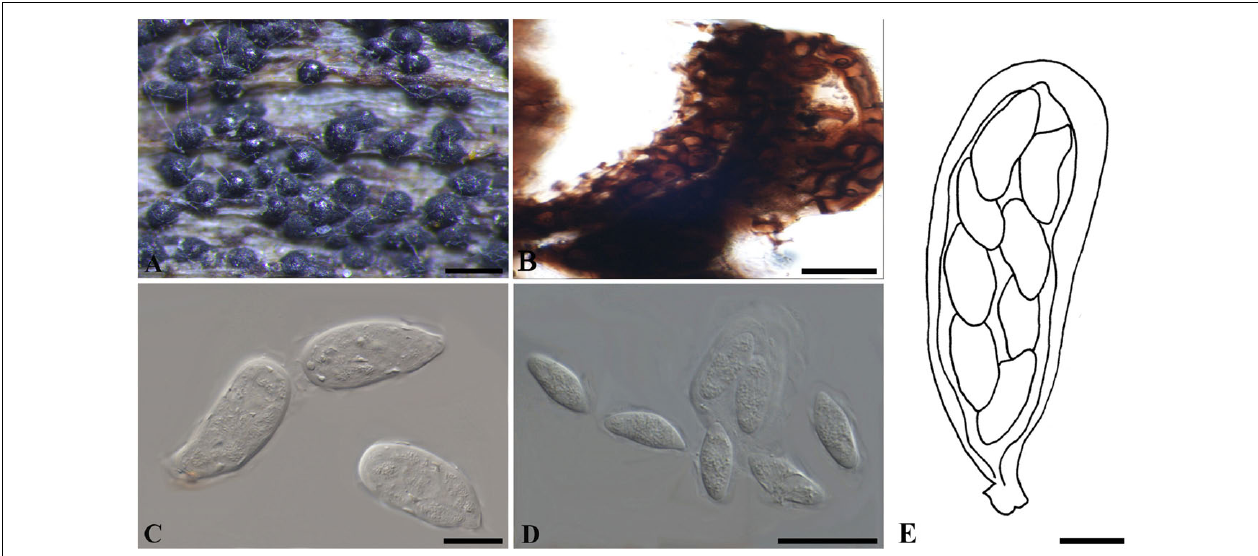
FIGURE 5 | Neofusicoccum cruenta (W 10992, holotype ). (A) Ascomata erumpent through a leaf surface. (B) Part of the peridium. (C,E) Asci. (D) Ascospores. Scale bars: (A) = 200 µ m, (B,E) = 10 µ m, (C,D) = 20 µ m.